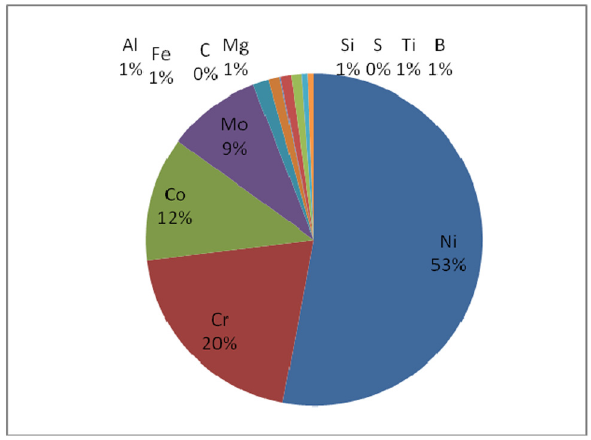
Figure 1: Chemical composition of alloying elements in Inconel